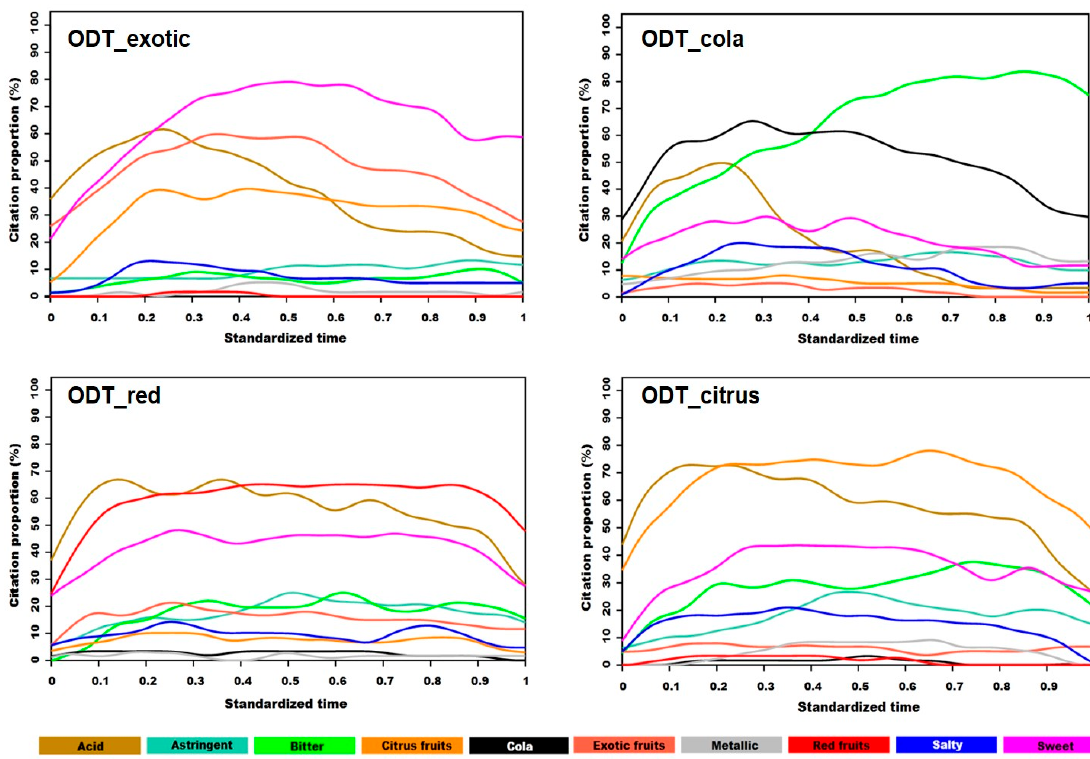
Figure 2. Standardized TCATA (Temporal Check-All-That-Apply) curves of four ODTs (Orally Disintegrating Tablets).